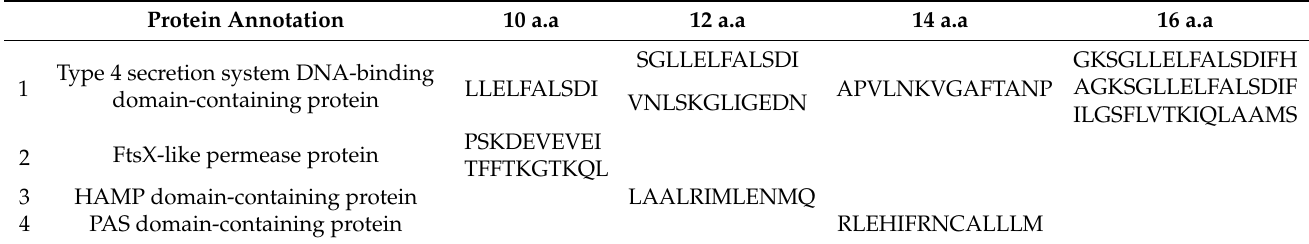
Table 1. All selected epitope